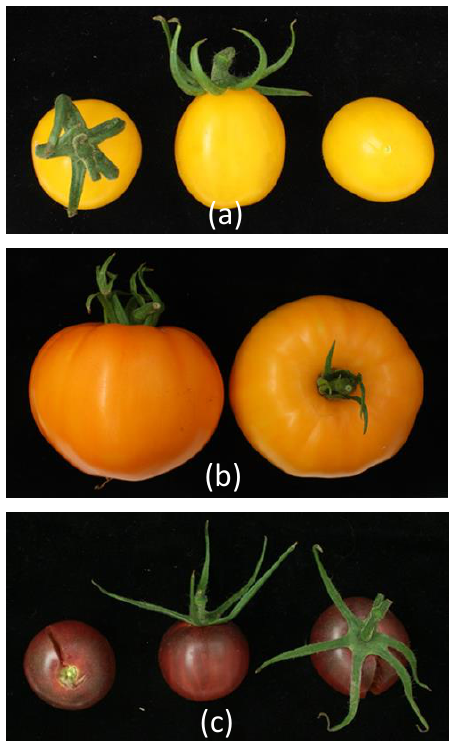
Figure 11. ( a ) RF_032 with the yellow flesh mutation; ( b ) RF_006 Tangerine mutation; and, ( c ) RF_ 029 with the old-gold-crimson and green flesh mutations.